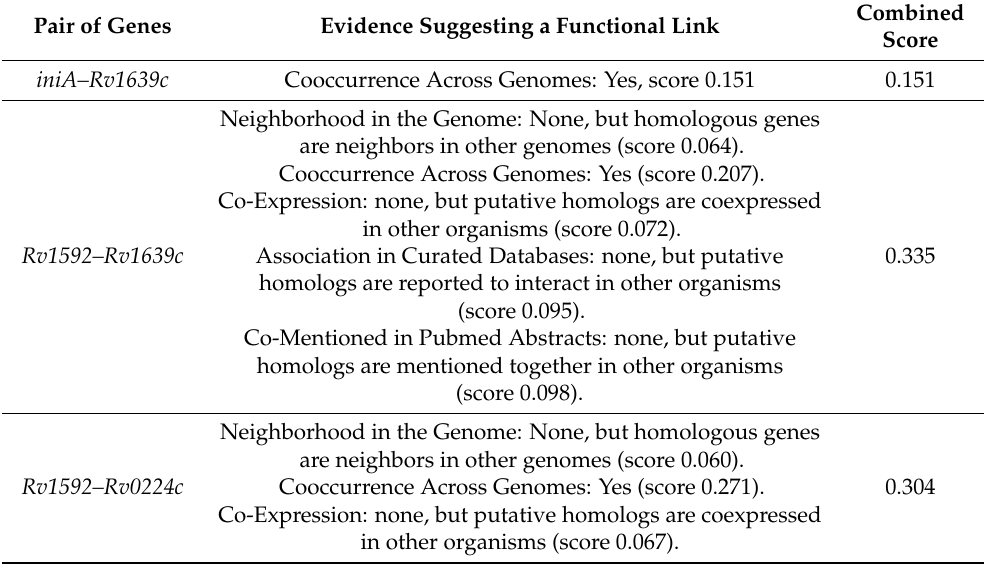
Table 4. The predicted interactions between pairs of the six targeted genes. Pair of